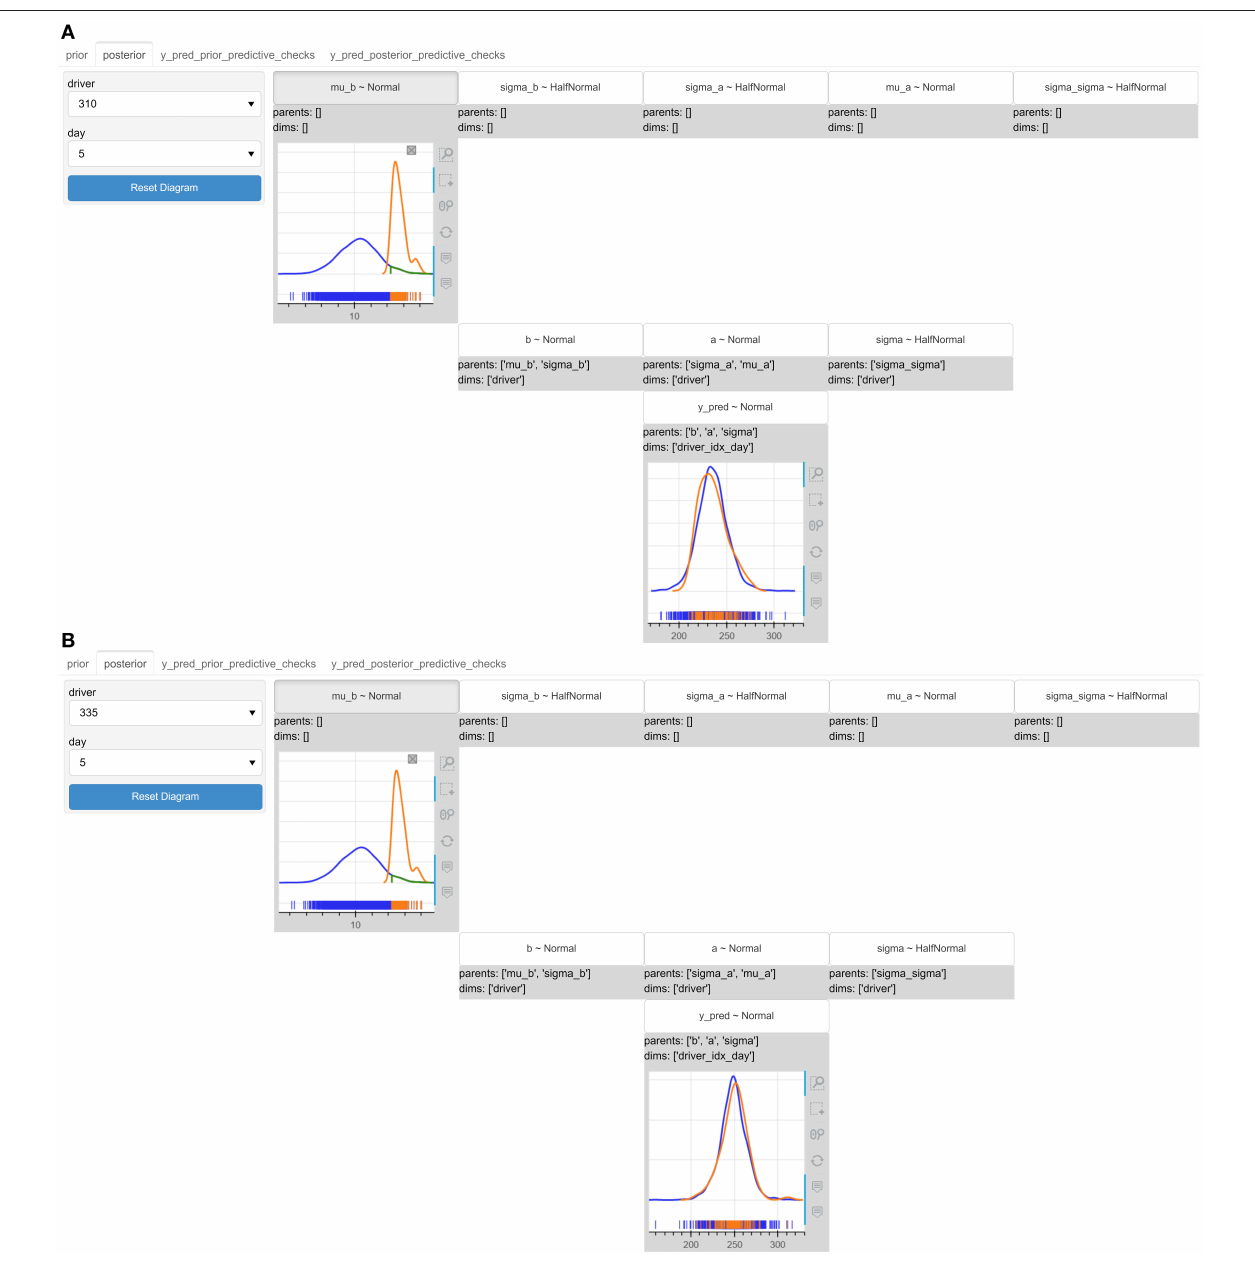
FIGURE 9 | The interactive probabilistic models explorer of the reaction times hierarchical model. We compare drivers 310 and 335 and observe the posterior predictive distribution of the reaction times on day 6 (indexed by 5) setting a condition mu b > 12.1. (A) The initial (in blue) and re-estimated (in orange) posterior predictive distribution of the reaction times for driver 310 on day 6. (B) The initial (in blue) and re-estimated (in orange) posterior predictive distribution of the reaction times for driver 335 on day 6. Driver 310 seems more robust to a possible worst case of high slopes